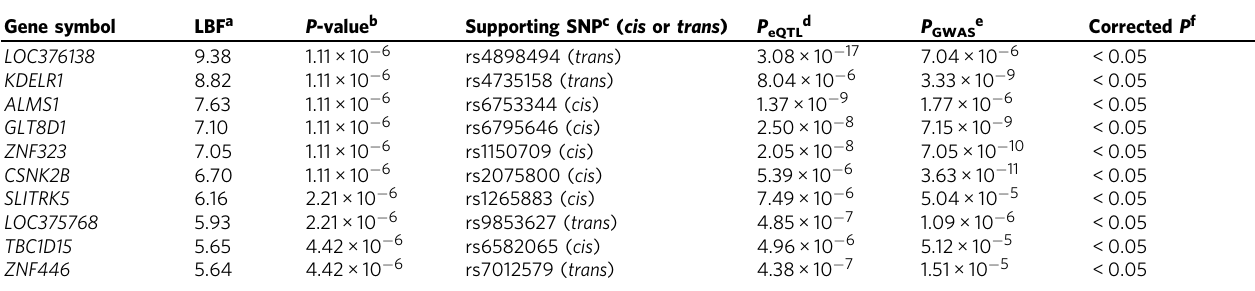
Table 1 Sherlock integrative analysis identi fi es ALMS1 , GLT8D1 , and CSNK2B as schizophrenia risk genes Gene symbol LBF